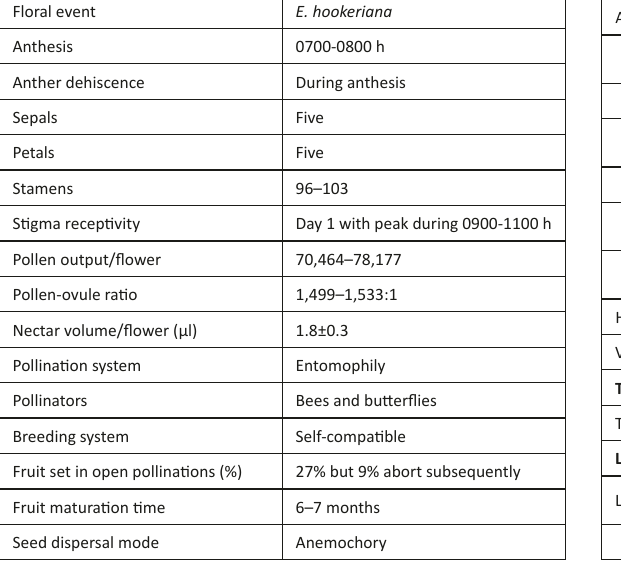
Table 1. Floral, breeding and fruiting aspects of Eriolaena hookeriana